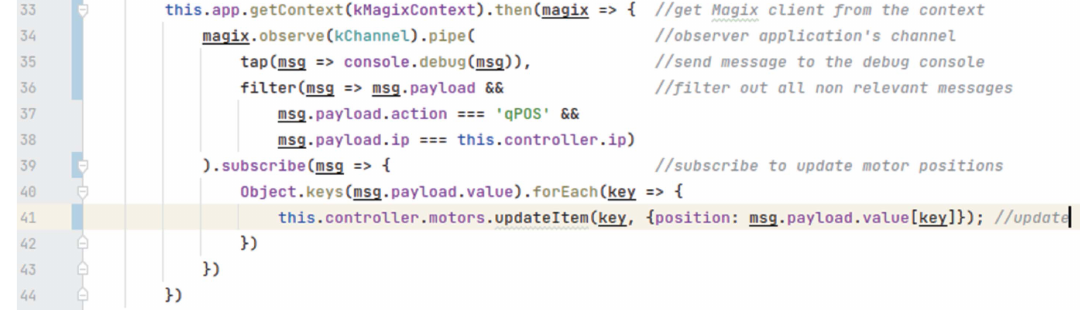
Figure 8 Example of a reactive update for ‘move’ action for motors.